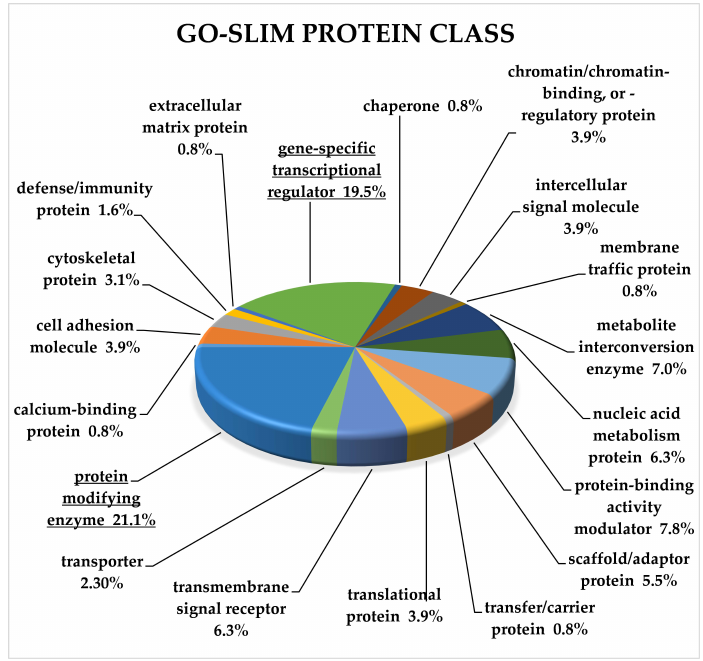
Figure 4. GO-Slim analysis of target genes of up-regulated miRNAs in CRC. Classification is ac- cording to protein class terms, and all terms are plotted. Significantly overrepresented terms are underlined ( p < 0.01; FDR < 0.01). FDR—false discovery